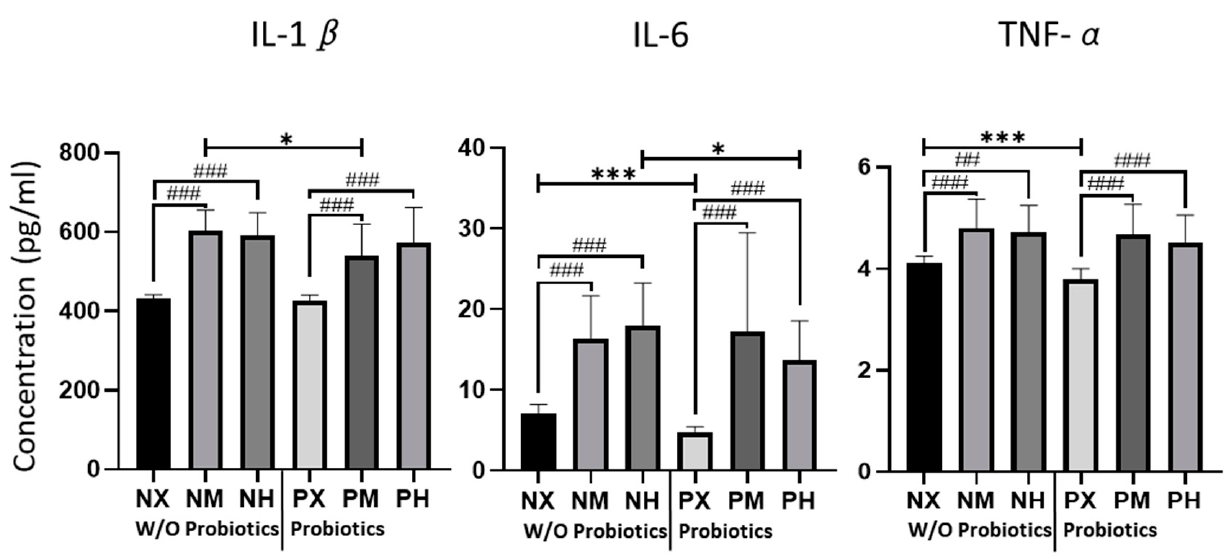
Figure 2. Effect of exercise and probiotics ingestion on inflammatory cytokines in the brain. Summary bar graphs showing the concentrations of IL-1 β (left panel), IL-6 (middle panel), and TNF- α (right panel) in cerebellar lysate from mice brains. Cytokines were detected by ELISA (enzyme-linked immunosorbent assay). The cytokine level changes depending on the exercising intensity and probiotics intake of mice. Increasing or decreasing tend to be similar, regardless of the type of cytokine. Values are presented as mean ± SD, ##; p < 0.01, ###; p < 0.001. Significant difference was indicated by One-way ANOVA. *; p < 0.05, ***; p < 0.001. Significant difference was indicated by independent t -test. N, no probiotics; P, probiotics; M, moderate-intensity exercise; H, high-intensity exercise; X, no exercise. Table 3. Statistical values of cytokines for the concentrations of IL-1 β (left panel), IL-6 (middle panel), and TNF- α (right panel) in cerebellar lysate from mice brains. Cytokines were detected by ELISA. Values are presented as M (mean, pg/mL) and SD (Standard Deviation). N, no probiotics; P, probiotics; M, moderate-intensity exercise; H, high-intensity exercise; X, no exercise.